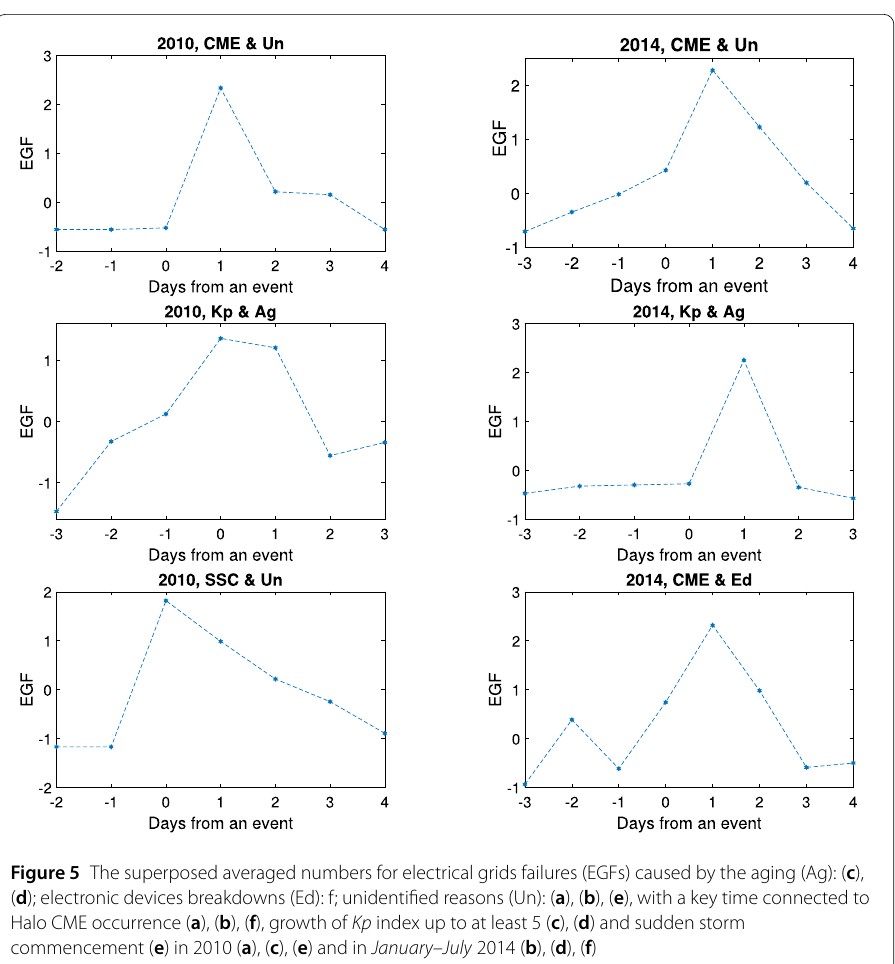
Figure 6 Histogram of Kp index values for chosen 30 days (details in the